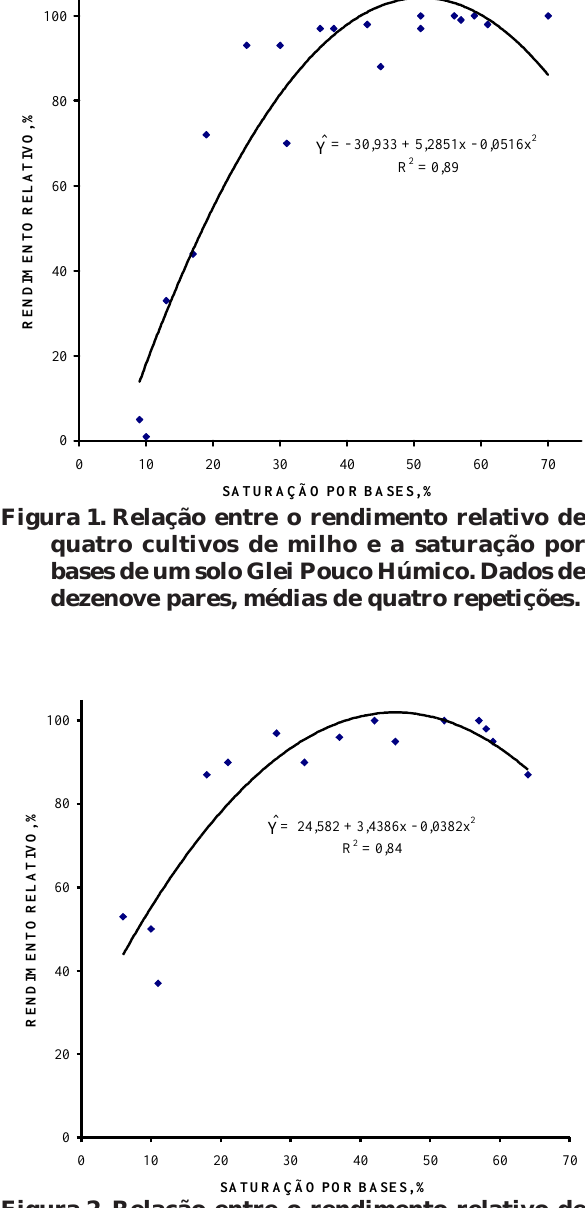
Figura 2. Relação entre o rendimento relativo de três cultivos de soja e a saturação por bases de um solo Glei Pouco Húmico. Dados de quinze pares, médias de quatro